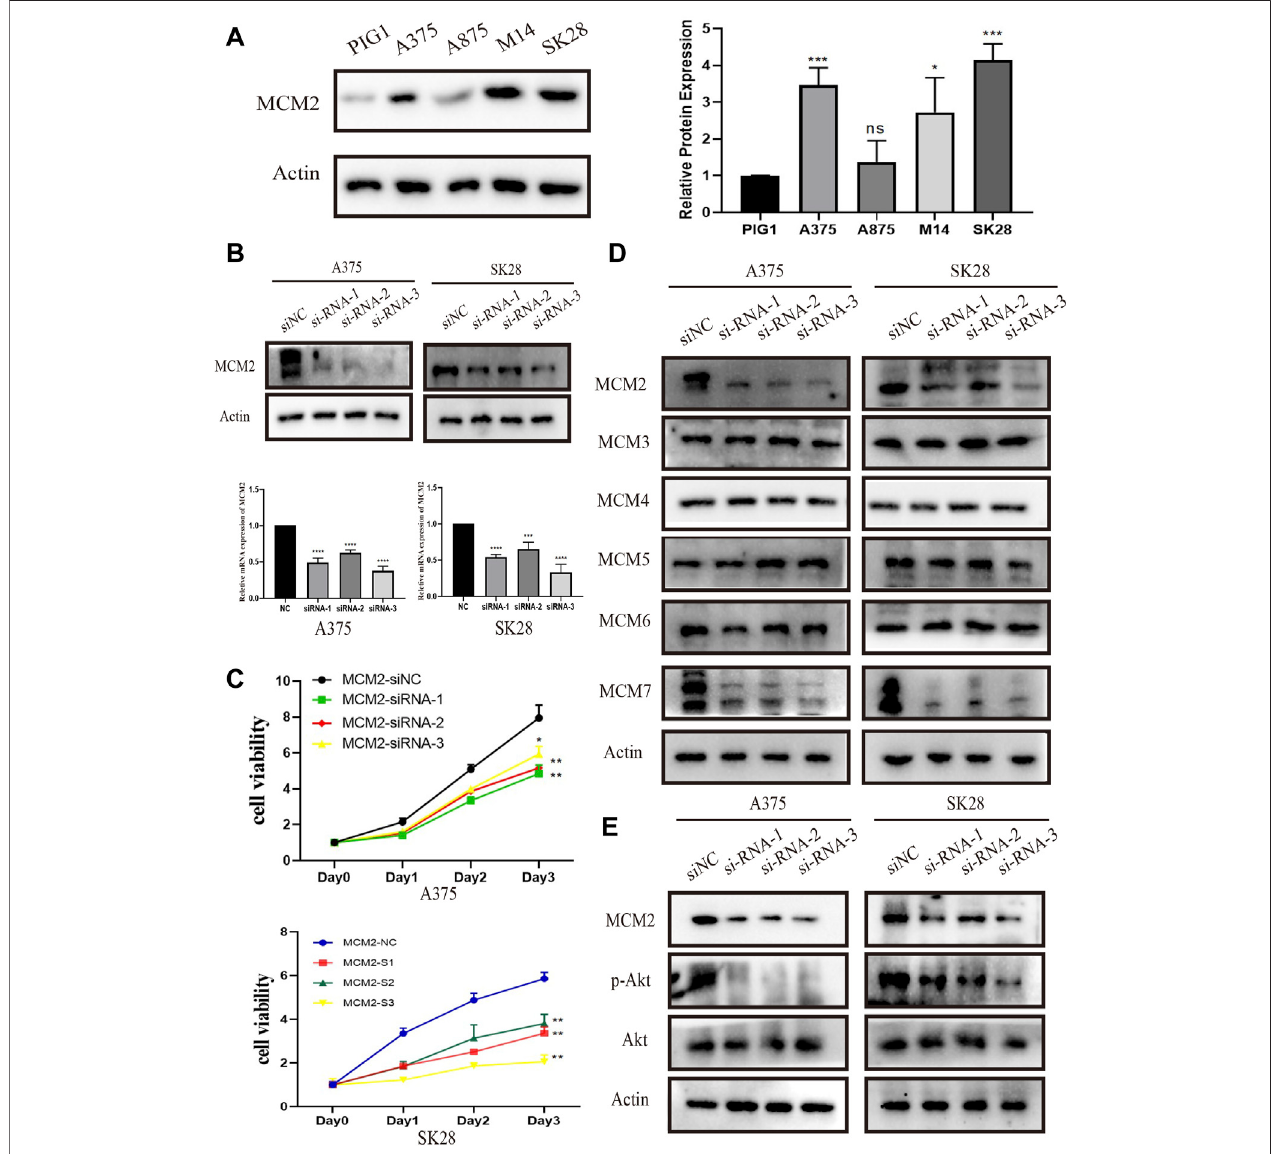
FIGURE13 | MCM2 isupregulatedand promotes cell proliferation in SKCM in vitro . (A) Therelativeexpression ofMCM2 in SKCM celllines(compared with thatof actin) examined via Western blotting. (B) MCM2 was successfully downregulated in the A375 and SK28 cell lines in protein and transcriptional level by siRNA. (C) The MCM2 knockdown signi fi cantly suppressed cell proliferation by CCK8 assay. (D) The side-effect of MCM2 knockdown to other MCM proteins. (E) The MCM2 knockdown signi fi cantly suppressed the phosphorylation of Akt.